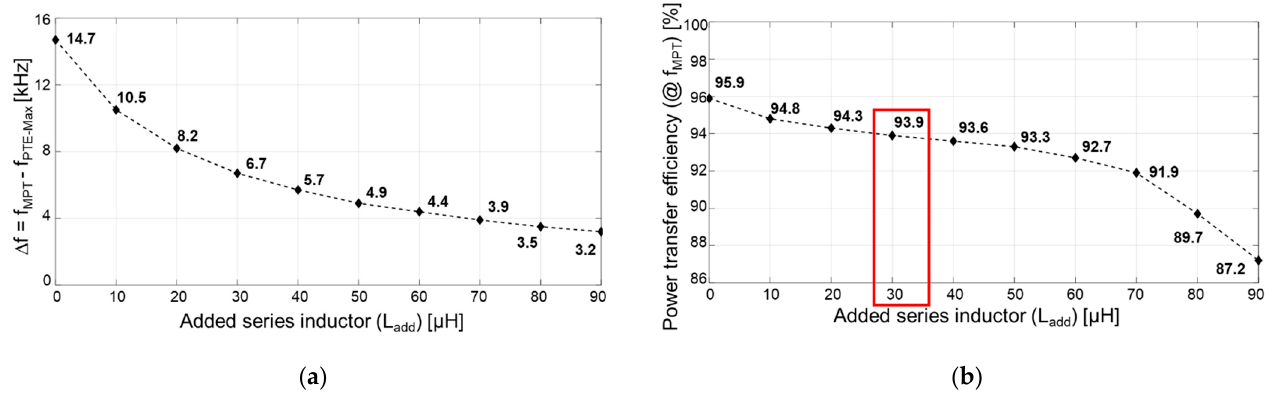
Figure 16. The difference between the MPT frequency and the maximum PTE frequency, and the power transfer efficiency change at the MPT frequency according to the change in the series inductor (L add-tx , L add-rx ): ( a ) change in the difference between the MPT frequency and the maximum PTE frequency ( ∆f) ; ( b ) change in the power transfer efficiency change at the MPT frequency.